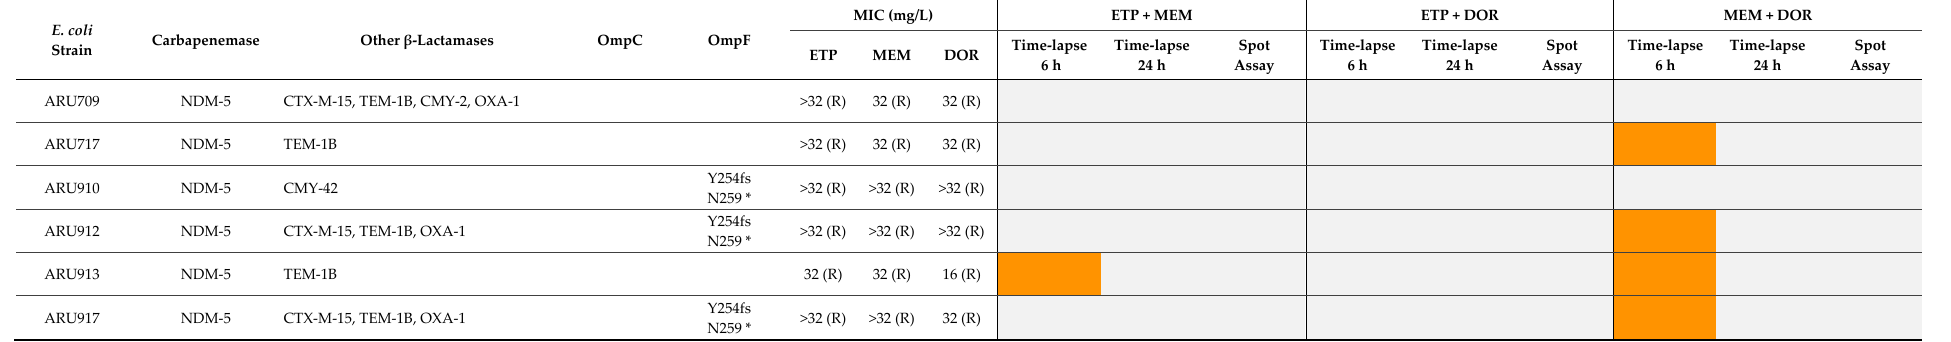
Table 1. Summary of results from time-lapse microscopy experiments (6 and 24 h) and spot assay (24 h) for double-carbapenem combinations against clinical carbapenemase-producing E. coli . MIC values for ertapenem, meropenem, and doripenem are classified according to EUCAST clinical breakpoints, version 12.0. Amino acid changes in β -lactamases are written in parentheses. Detected loss of function mutations in porin-encoding genes (OmpC/F) are presented. Carbapenem combinations showing an enhanced effect in the time-lapse microscopy experiments or synergy in the spot assay are highlighted in orange. Synergistic combina- tions that also showed a bactericidal effect are marked with a thick outline.